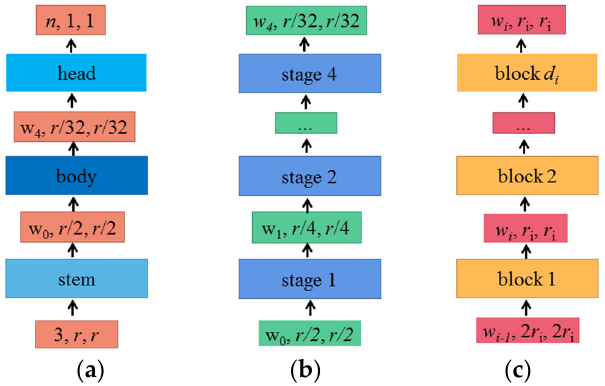
Figure 2. Structural framework of RegNet: ( a ) network; ( b ) body; ( c ) stage.